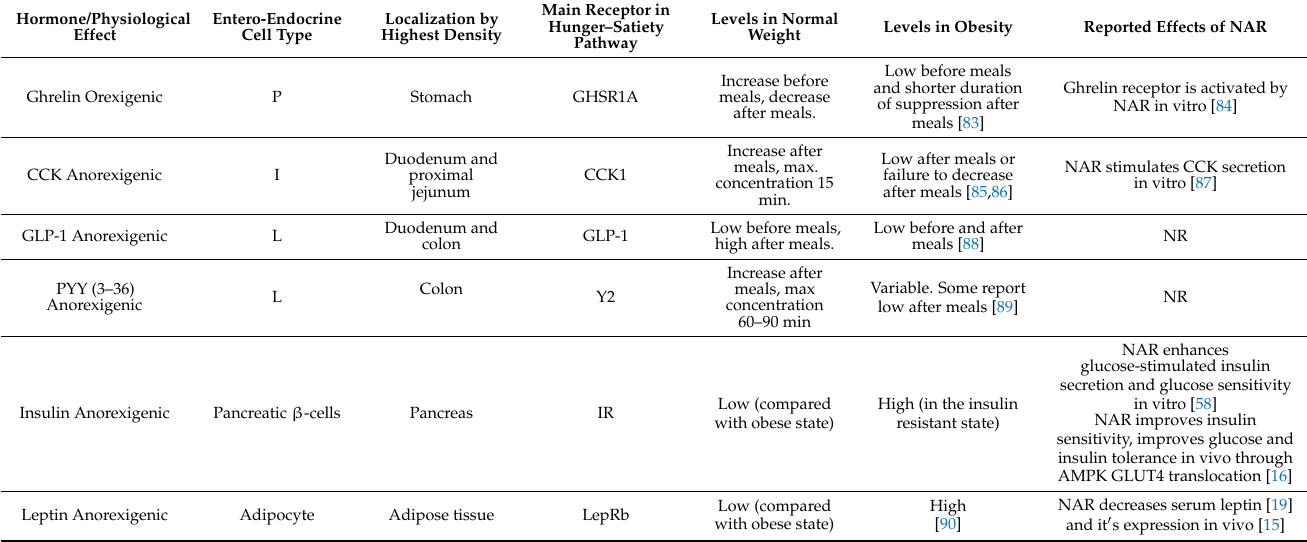
Table 2. Main enterohormones involved in the hunger–satiety pathway, and findings from in vivo and in vitro studies evaluating metabolic effects of naringenin (NAR)